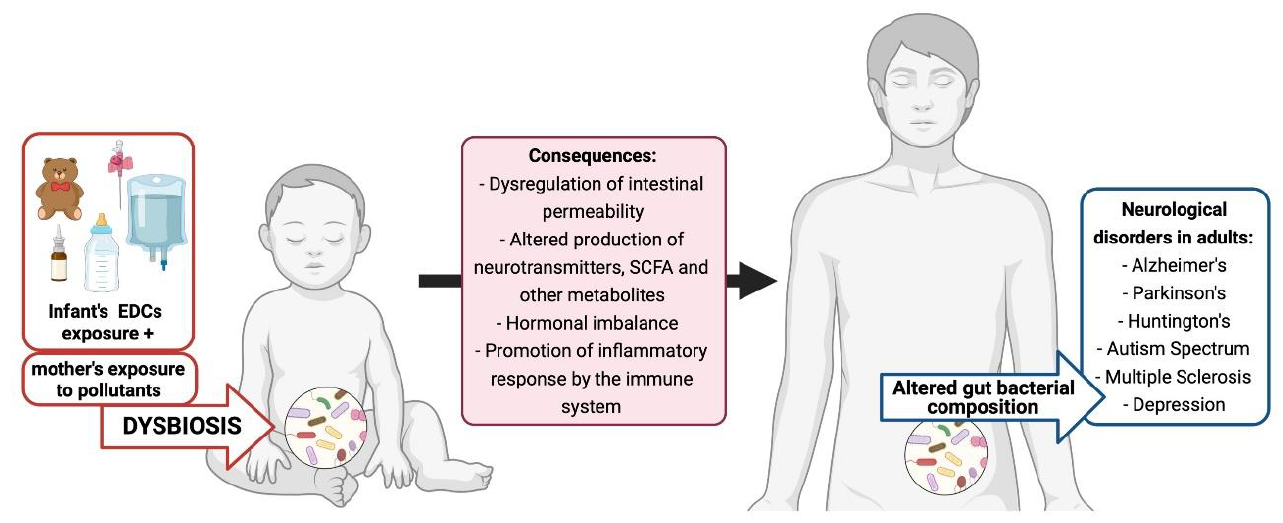
Figure 3. EDC exposure, early dysbiosis, and neurological disorders in adults.